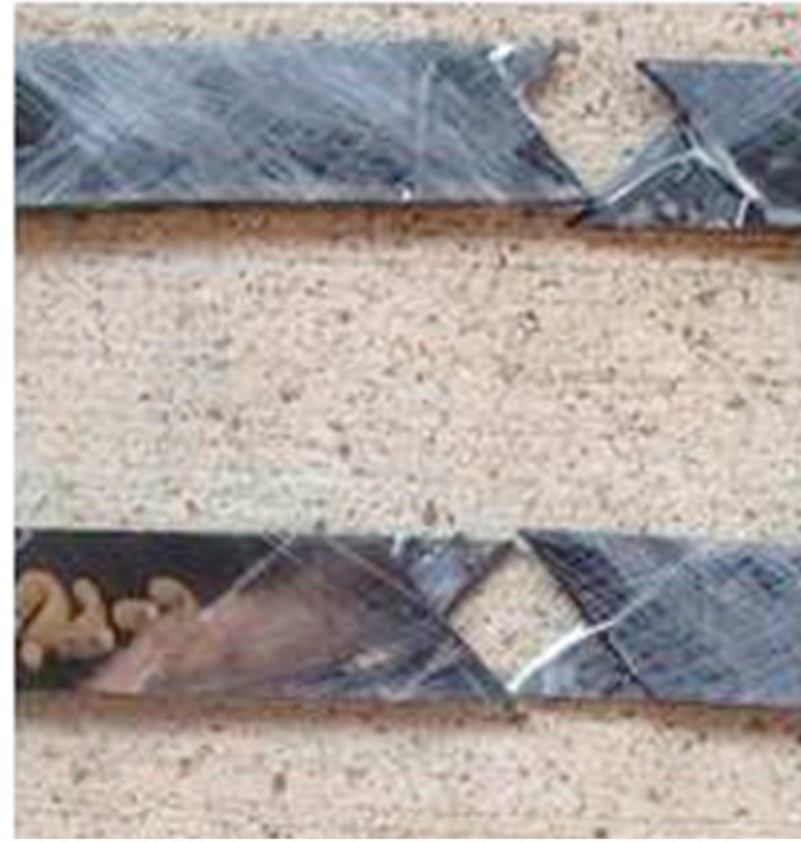
Figure 6. Characteristic failure of off-axis shear